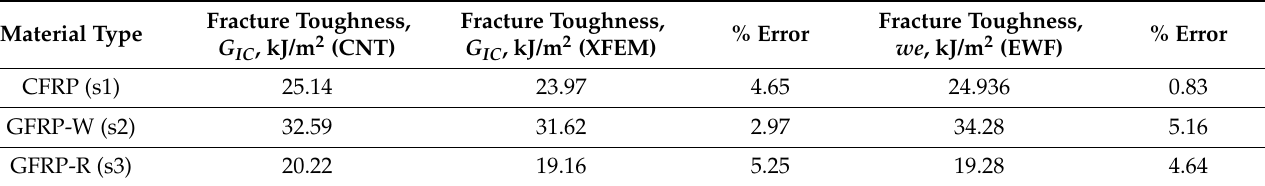
Table 4. Comparison between fracture toughness measured using CNT, XFEM and